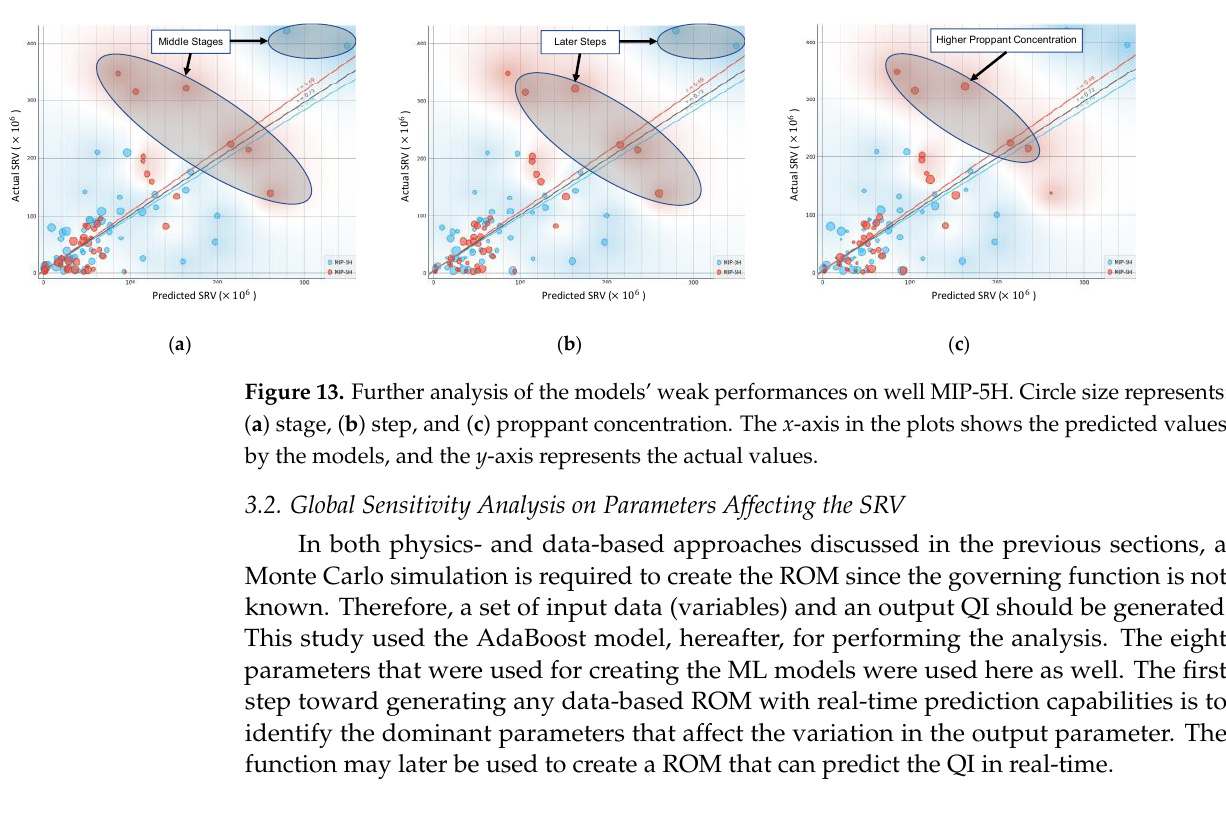
Figure 12. Models’ performances, ( a ) AdaBoost, ( b ) KNN, ( c ) Random Forest, ( d ) ANN, and ( e ) Stack. The x -axis in the plots shows the predicted values by the models, and the y -axis represents the actual values.